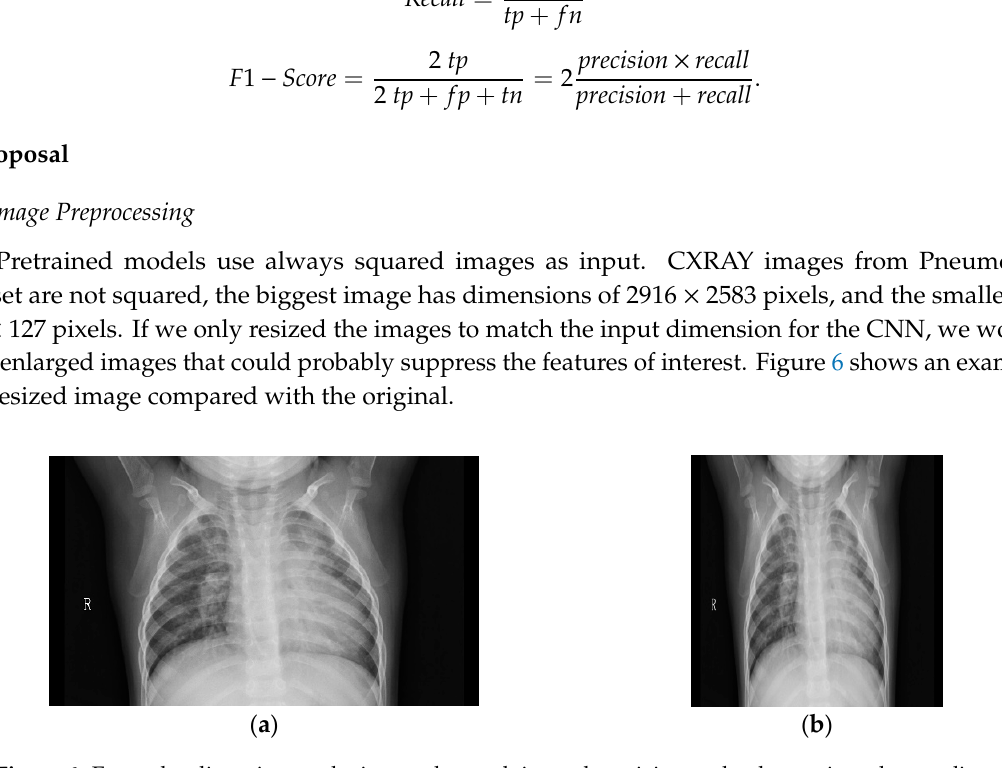
Figure 6. Examples distortion on the images by applying only resizing to the dataset in order to adjust them to the input shape of the Convolutional Neural Networks (CNN) model. ( a ) shows the original image of a person with pneumonia (https://data.mendeley.com/datasets/rscbjbr9sj/2); ( b ) shows the resized image to 299 × 299 pixels.